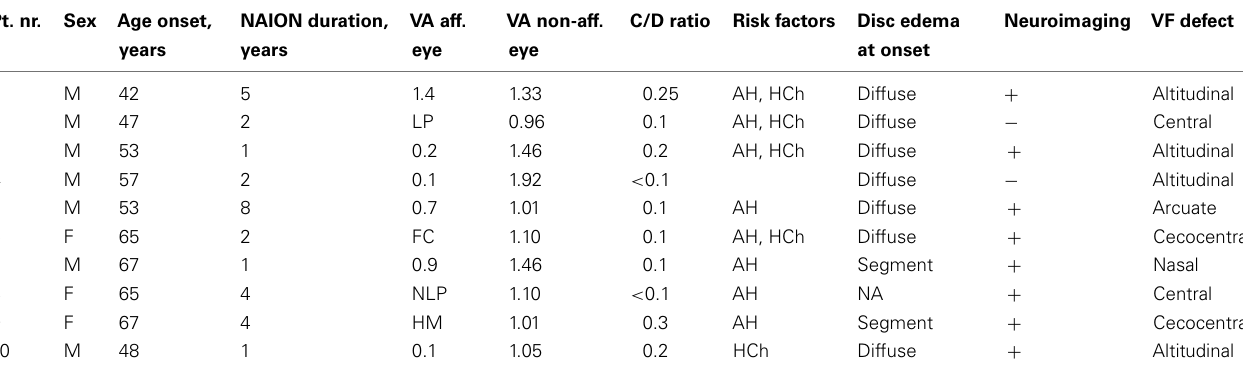
Table 1 | Summary of the demographics and clinical findings of the NAION patients at